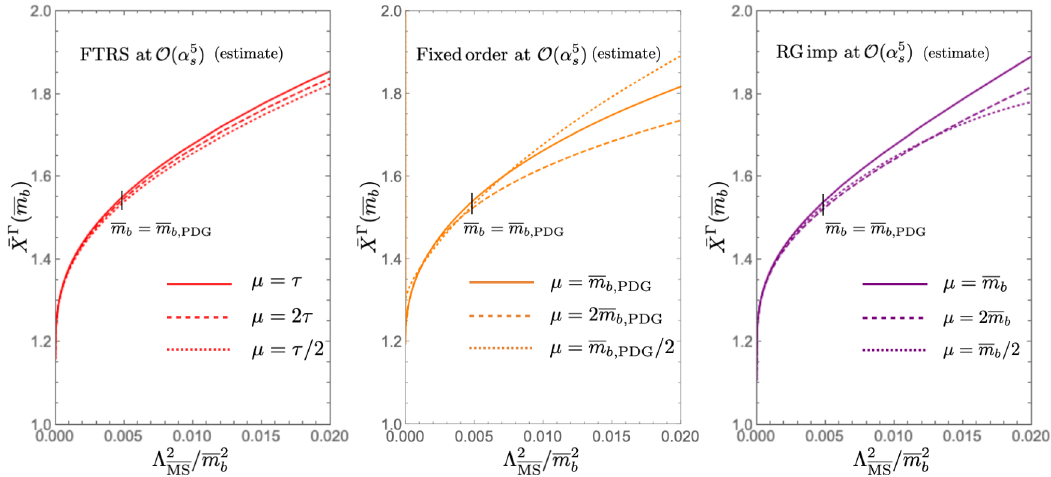
Figure 8 . Comparison of ¯ X Γ by FTRS method, and by fixed-order and RG-improved calculations up to order O ( α 5 ) , which are estimated using 5-loop beta function. Other parameters and notations s are the same as in figure